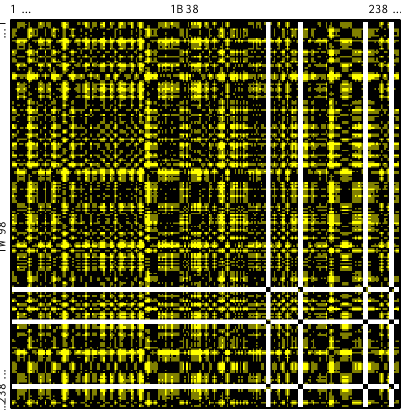
Fig. 10. Matrix of compatibility degrees between sequences of energy profiles for two molecules PDB ID: 1B38 (Crystal Structure of Human CDK2 with ATP) and PDB ID: 1W98 (Structural Basis of CDK2 Activation by Cyclin E).